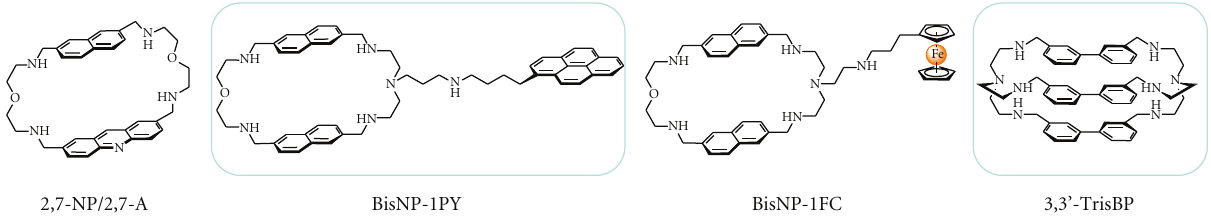
Figure 8: Structures of the four most promising members of the macrocyclic